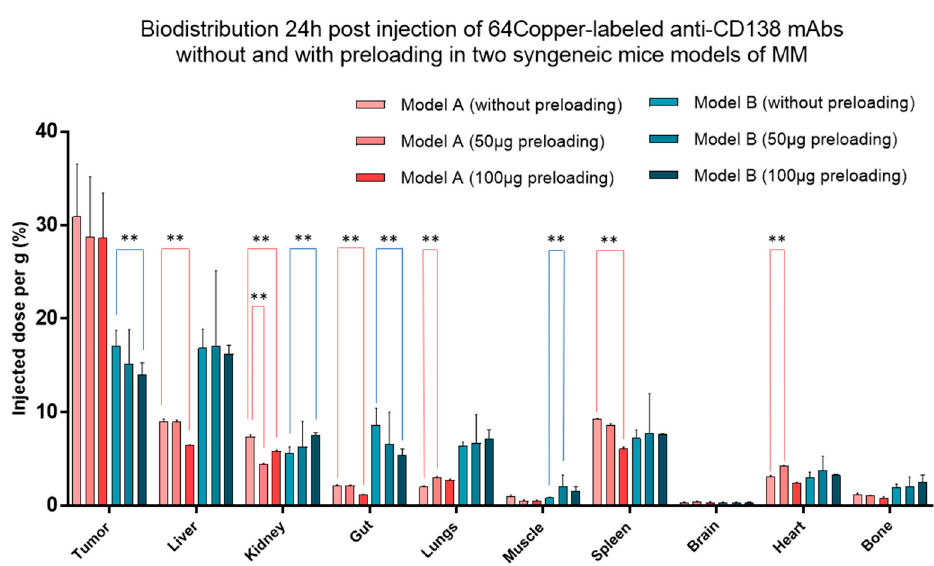
Figure 2. PET-derived biodistribution in two syngeneic models of MM (Model A: MOPC 315 cells in balb/c; Model B: 5T33 MM cells in C57BL/KaLwRij). Tumour-bearing mice were imaged after injection of 64Copper-labelled anti-CD138 mAbs associated or not to 50 µg or 110 µg of unlabelled mAbs 4 h before. Results are completely different from one mouse model to another (non-parametric test). Values are expressed in percentage of the injected radioactive dose per gram of tissue and presented as mean ± SD. **: p- value ≤ 0.01.